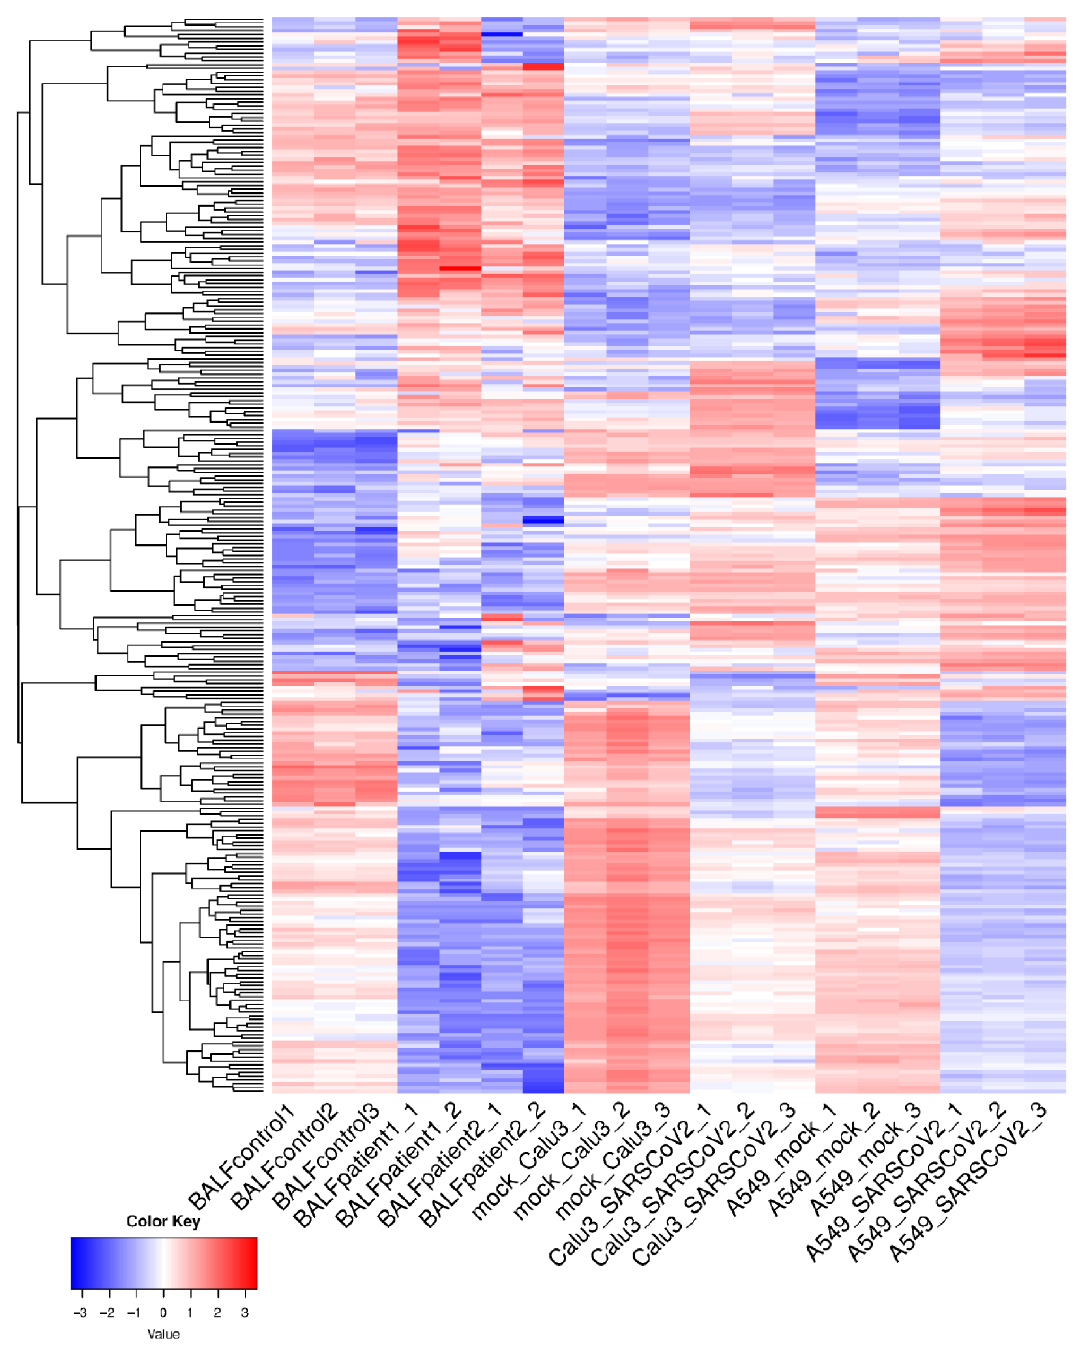
Figure 1. Hierarchical clustering with Euclidean distance of common differentially expressed genes and lncRNAs across all samples.